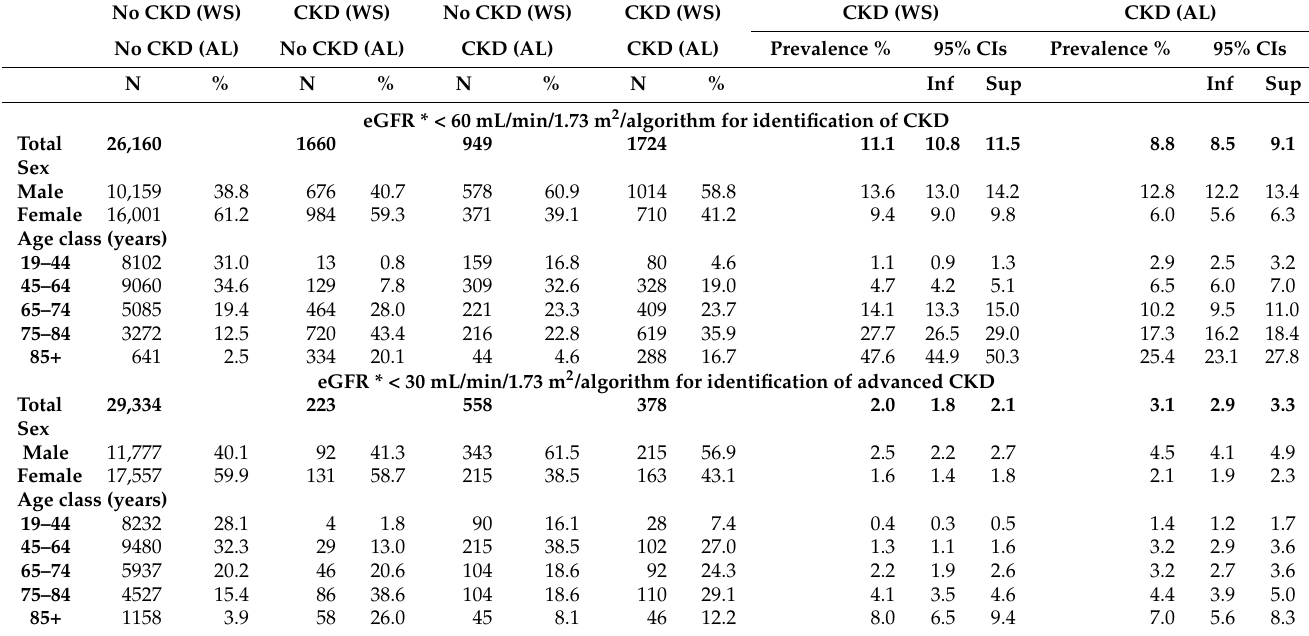
Table 2. Characteristics of patients with or without Chronic Kidney Disease CKD-working standard (WS) and CKD-algorithm (AL) and prevalence of CKD in both definitions, by sex and age class.